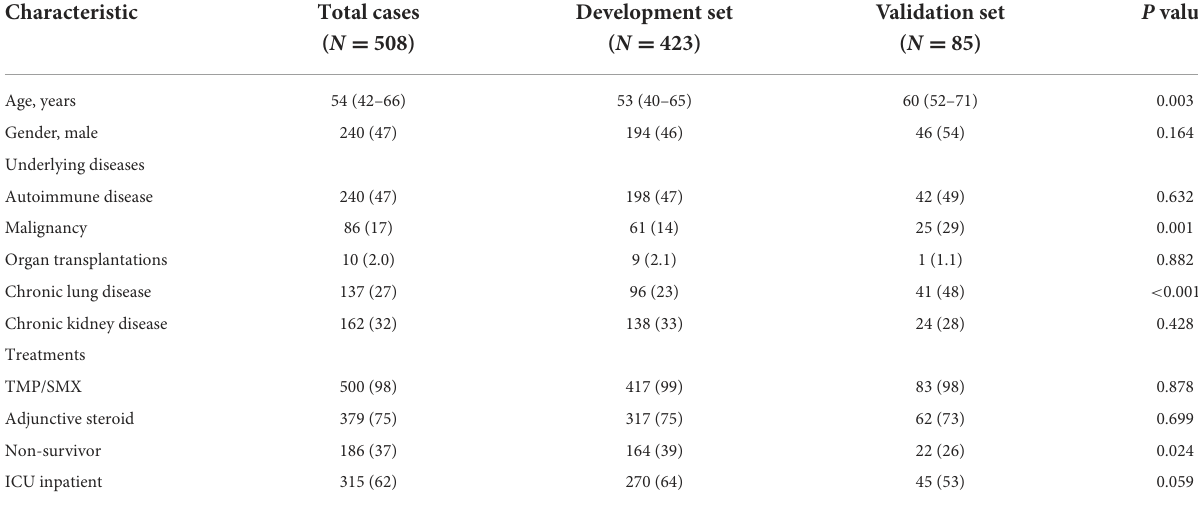
TABLE 1 Baseline clinical characteristic of PCP